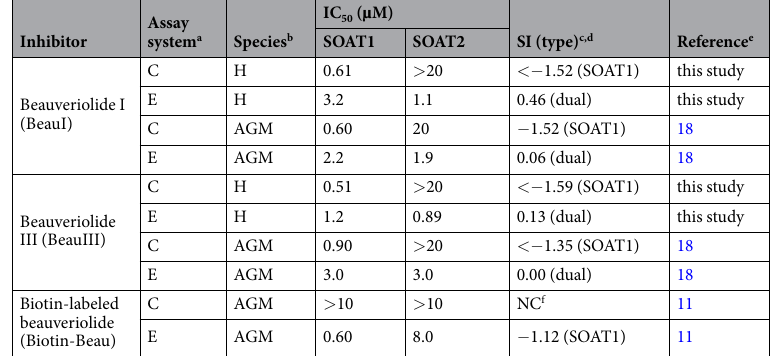
Table 1. Selectivities of beauveriolides toward SOAT isozymes. a C: cell-based assay; E: enzyme-based assay. b H: Human; AGM: African green monkey. c Selectivity index (SI): log [IC 50 for SOAT1/IC 50 for SOAT2]. d Based on SI values, SOAT inhibitors were classified into three groups: dual type, − 1.00 ≤ SI ≤ + 1.00; SOAT1-selective type,